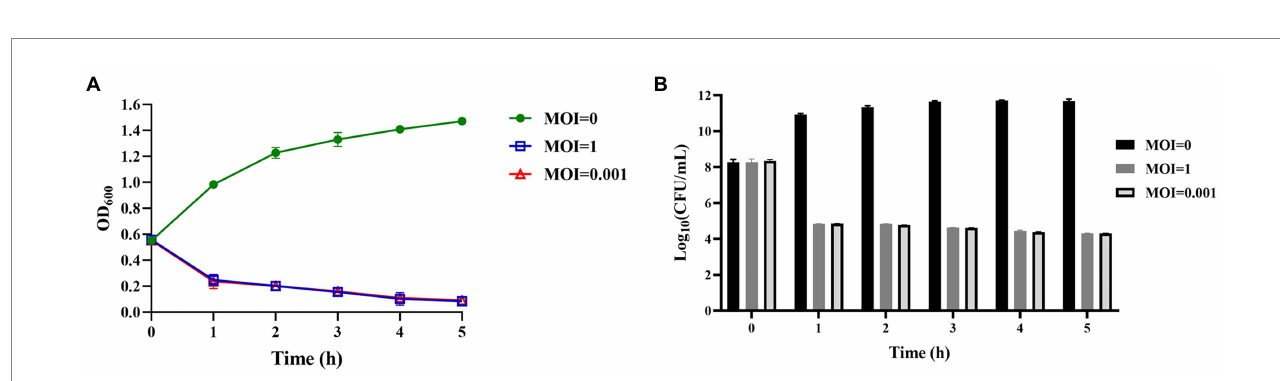
FIGURE 6 Assessment of the efficacy of phage vB_KpnS_SXFY507 against SXFY507 in vitro . (A) The variation of OD600 when different titers of phage vB_KpnS_ SXFY507 were co-cultured with SXFY507. (B) Quantification of bacterial CFU when different titers of phage vB_KpnS_SXFY507 were co-cultured with